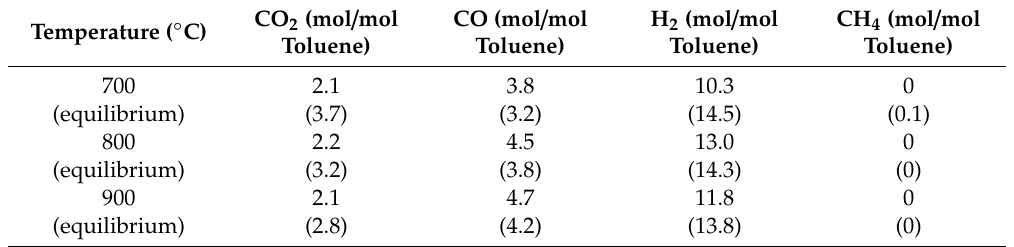
Table 1. Product yields for the gaseous products at the three di ff erent temperatures (S / C:3, GHSV: 61,200 h − 1 ).